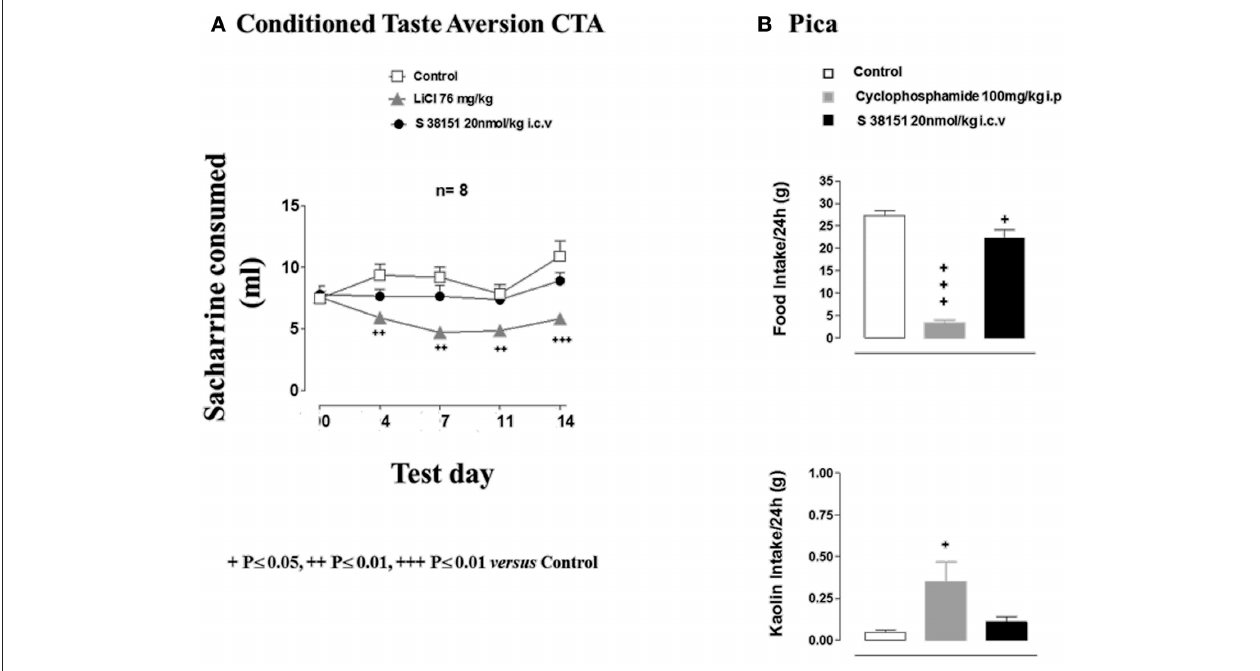
FIGURE 5 | The effects of S38151 on conditioned taste aversion and pica in Zucker fa/fa rats. (A) In the conditioned taste aversion test, after a period of habituation of the animals to the experimental protocol, Zucker fa/fa rats were presented with 0.2% saccharine for 20min after drinking water was removed from their cages for 18h (test day 0). Animals were then injected (i.p.) with vehicle or lithium chloride, or with S38151 (20nmol/kg, i.c.v). On test days 4, 7, 11, and 14, rats were presented with 0.2% saccharine, and the quantity consumed during a 20-min period was determined. Results are expressed as mean ± SEM ( n = 10–11 rats per group). Repeated measures